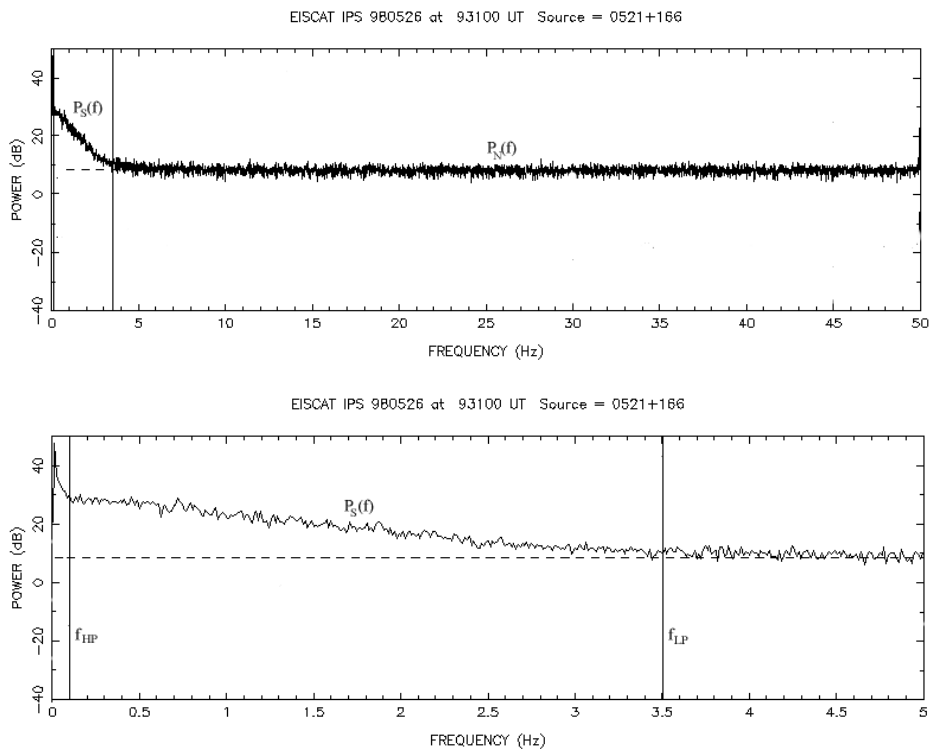
Fig. 1. An example of the power spectrum of the time-variations in detected intensity, calculated from EISCAT IPS measurements. The top panel shows the spectrum out to the Nyquist frequency (50Hz). The bottom panel is a close-up of the 0–5Hz frequency range, illustrating the position of the low-pass filter f LP , which filters out the white spectrum of stochastic noise at higher frequencies, and the high-pass filter f HP , which filters out slow time variations within the antenna and receiving